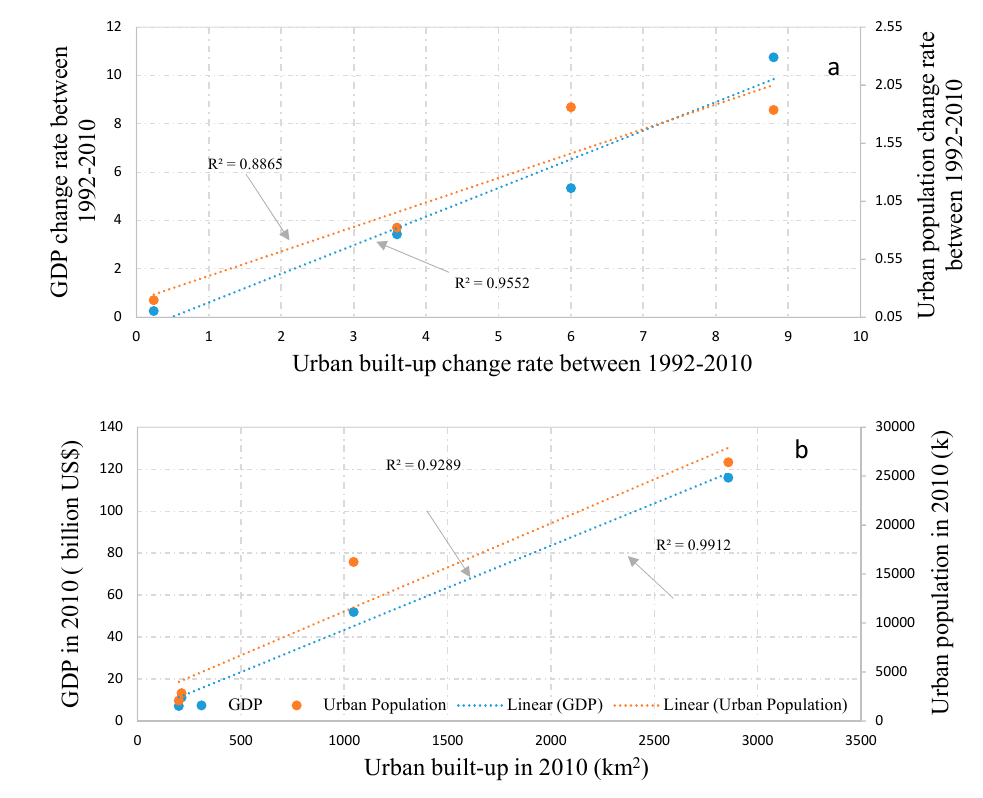
Figure 10. Relationship between urban built-up areas and socioeconomic data of GDP and population. The change rate between 1992 and 2010 was calculated as the net increase divided by the base number in 1992. All GDP and population data were acquired from the World Bank [76], except GDP data for Myanmar were acquired from its national statistics collected by our local collaborators.